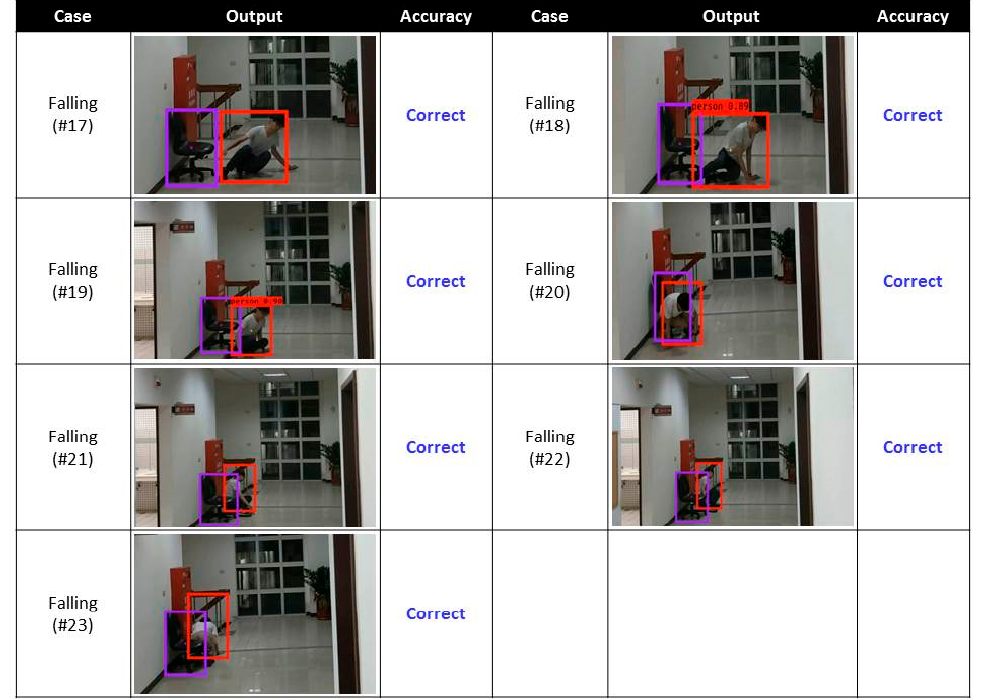
Figure 12. The test results of the effect of the person–chair ratio on IFADS’s accuracy.